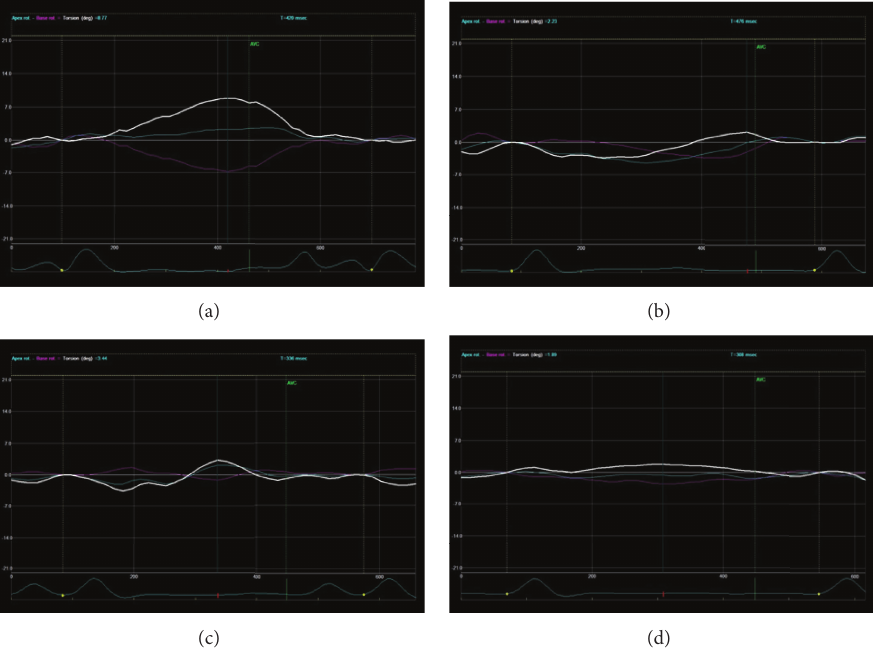
Figure 2: The same animal during atrioventricular pacing at the left ventricular (LV) apex (a), ventricular pacing at the LV apex (b), atrioventricular pacing at the lateral wall (c), and ventricular pacing at the lateral wall (d). LV twist was maintained at the same level as in sinus rhythm (Figure 1) when atrioventricular pacing was implemented at the LV apex. Atrioventricular or ventricular pacing at the lateral wall and ventricular pacing at the LV apex reduce twist